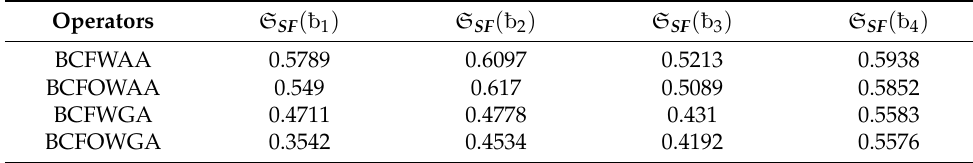
Table 3. The score values of the aggregated values given in Table 2.